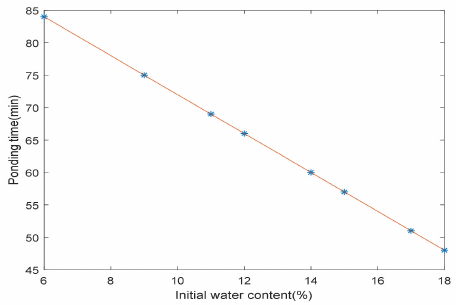
Figure 4. Initial moisture content versus time of water accumulation. * is the data points of the finite element simulation, the red line is fitted through the data